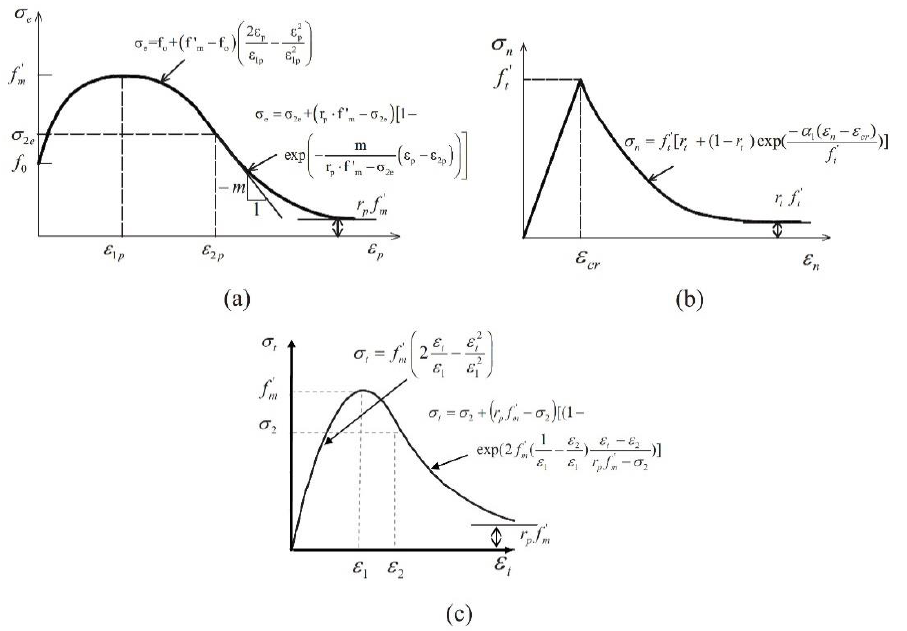
Figure 15. Constitutive models for ( a ) Stress-strain plasticity, ( b ) tensile behaviour and ( c ) full compressive behaviour (adepated from Ref. [309]).